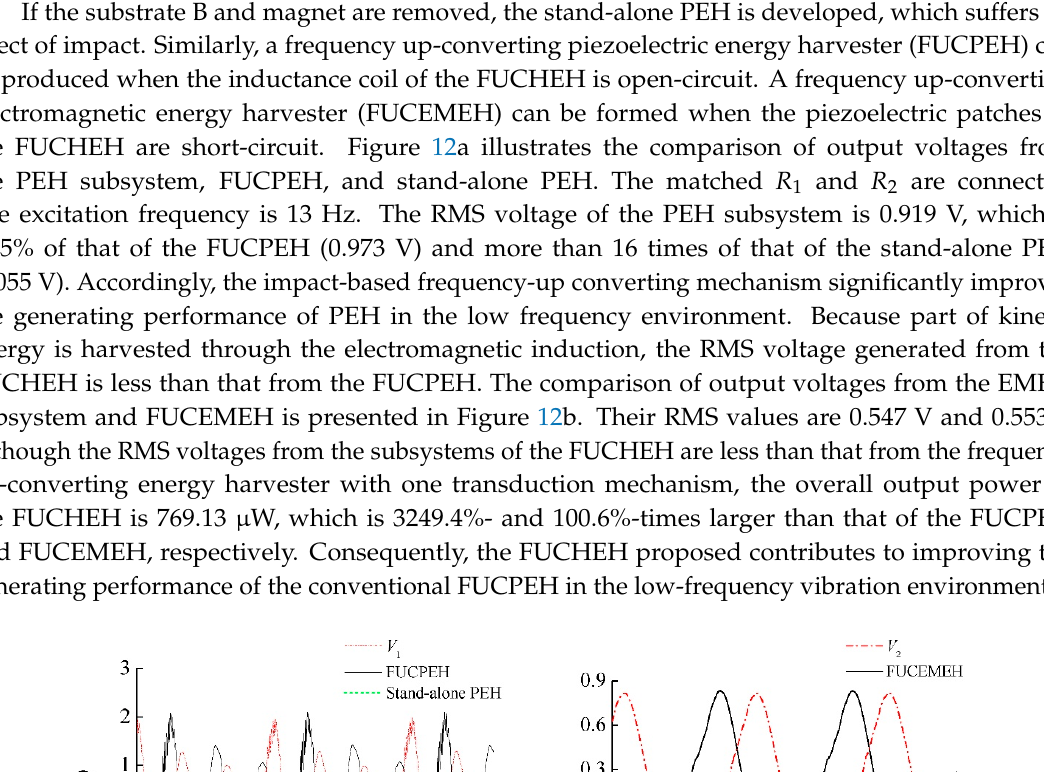
Figure 11. Sweep spectrum analysis for the output voltage frequency responses of the FUCHEH.